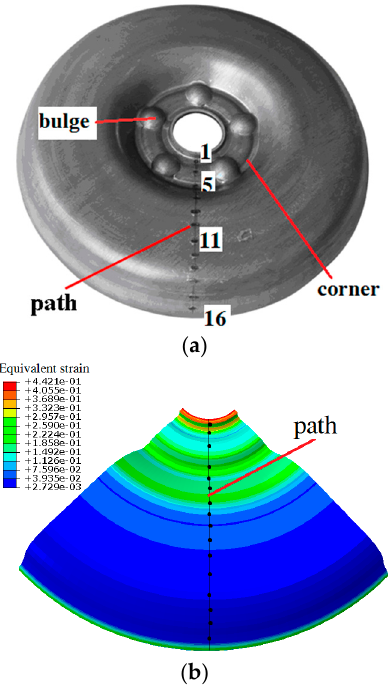
Figure 6. Experimental and simulative spokes: ( a ) experimental spoke; ( b ) simulative spoke. Table 4. Simulative and experimental results of the characteristic dimensions. Characteristic Dimension